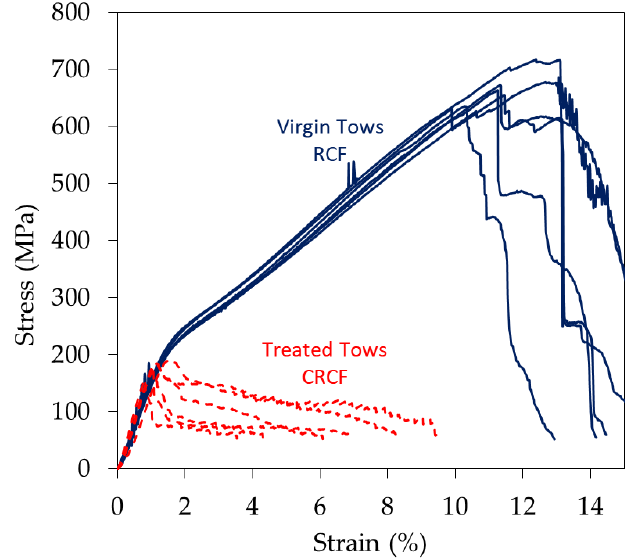
Figure 4. Stress-strain curves of the tows tested in tension before (solid blue line) and after (CRCF) (dotted red line) coating by electroless copper plating.